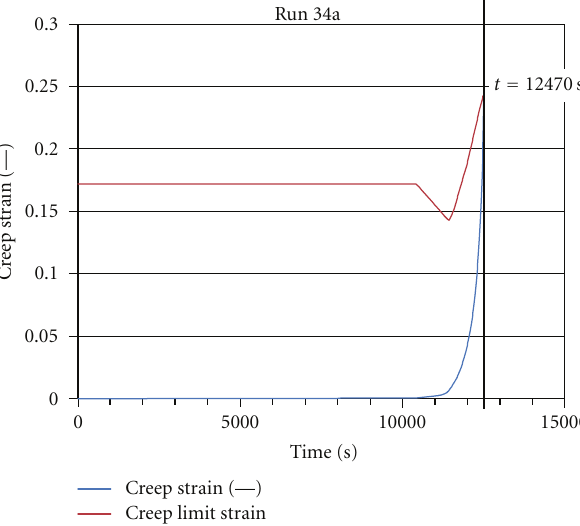
Figure 9: Accumulated creep strain and strain limit curve (failure at 12470